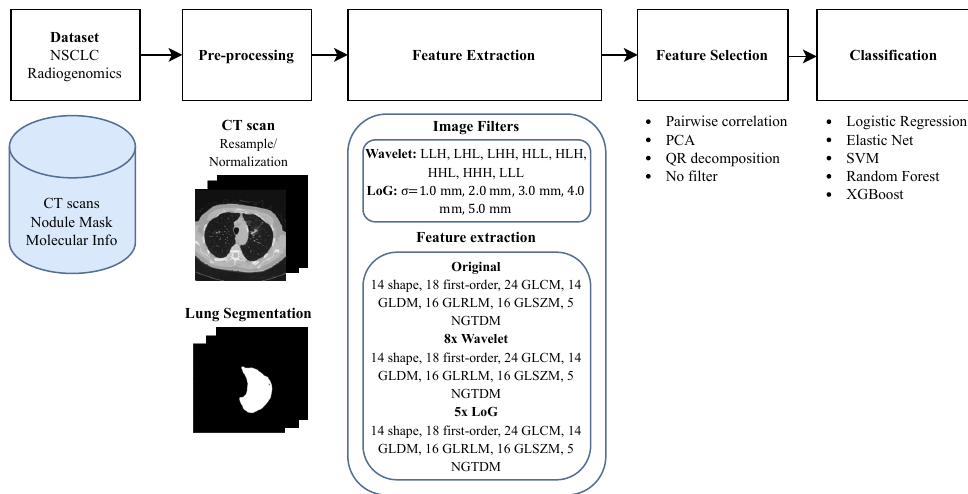
Figure 1. Overview of the classification approach for Epidermal Growth Factor Receptor (EGFR) mutation status prediction. Computed tomography (CT) images and segmentation masks of the lung are loaded into the software. Then, the wavelet and Laplacian of Gaussian (LoG) filters are applied to the original image and 1316 radiomic features of the region of interest (ROI) are extracted using the Pyradiomics package [22]. This process is performed for all images in the Non-Small-Cell Lung Carcinoma (NSCLC) dataset. Finally, various combinations of six classification models, three feature selection techniques, and a baseline without feature selection are implemented and